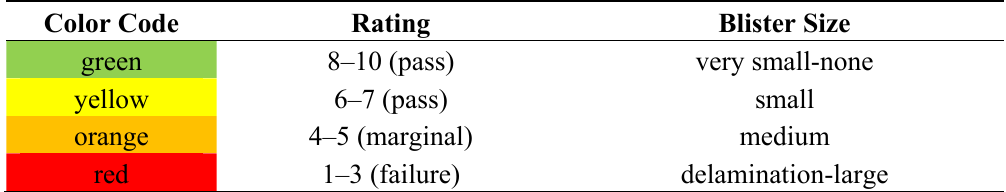
Table 2. Performance rating for ASTM 1654 Methods A and